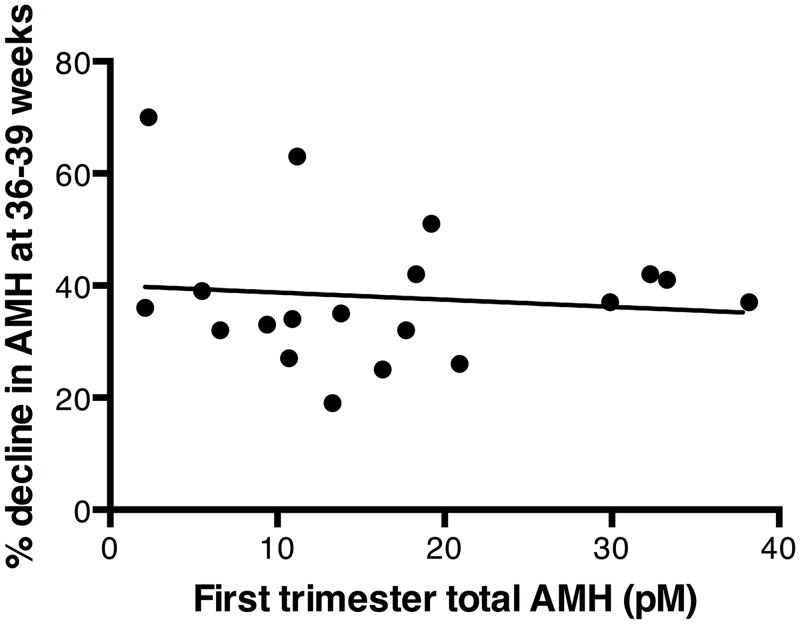
The magnitude of pregnancy-related decline was dissociated from a woman’s level of AMH.Each woman’s level of total AMH during the first trimester is plotted against the extent to which her total AMH levels declined by 36–39 weeks gestation. The two measures showed no significant correlation (R = - 0.04). 1 ng/ml of AMH = 7.14 pmol/L (pM).